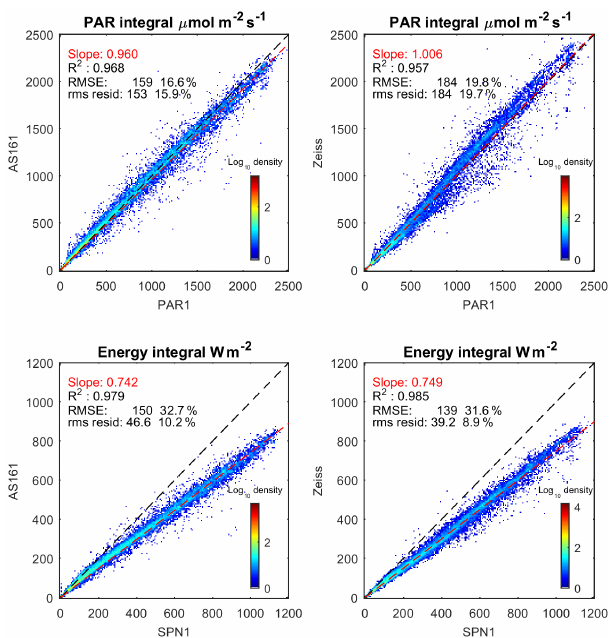
Figure 12. Comparisons of integrated PAR (400–700nm, quantum weighting) and energy (integrated over 380–1050nm) with the ad- jacent Kipp & Zonen PQS-1 PAR sensor and SPN1.